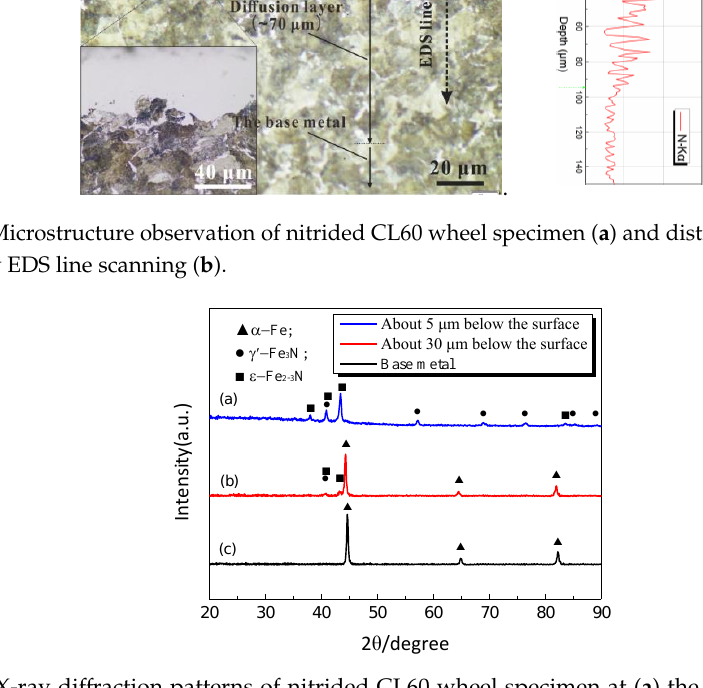
Figure 6. X-ray di ff raction patterns of nitrided CL60 wheel specimen at ( a ) the white bright layer, ( b ) the di ff usion layer and ( c ) the base metal and the as-received CL60 wheel.